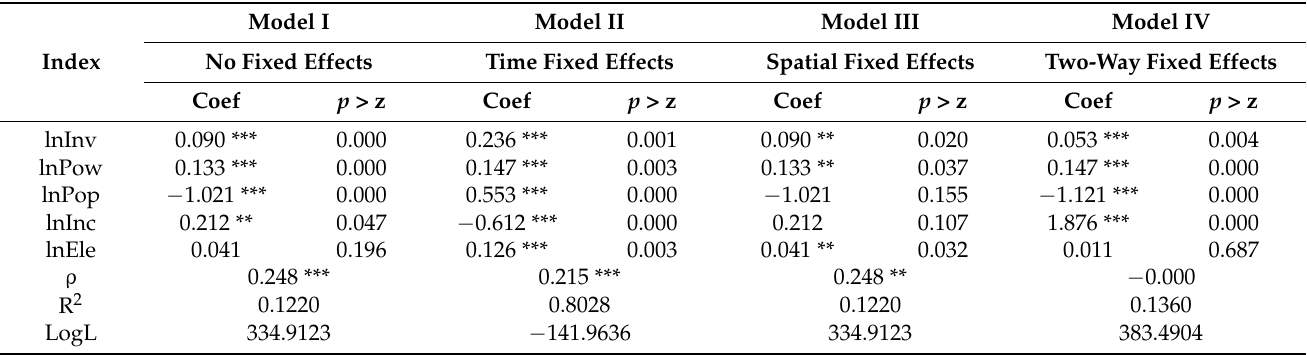
Table 9. Spatial measurement estimation result.